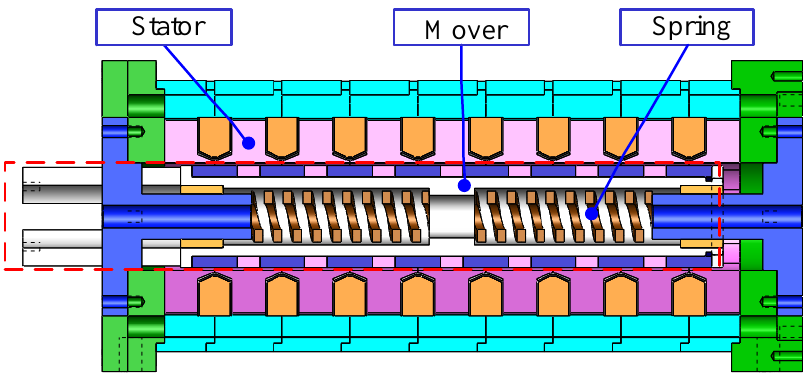
Figure 8. Cross-sectional view of the linear oscillating motor (LOM).